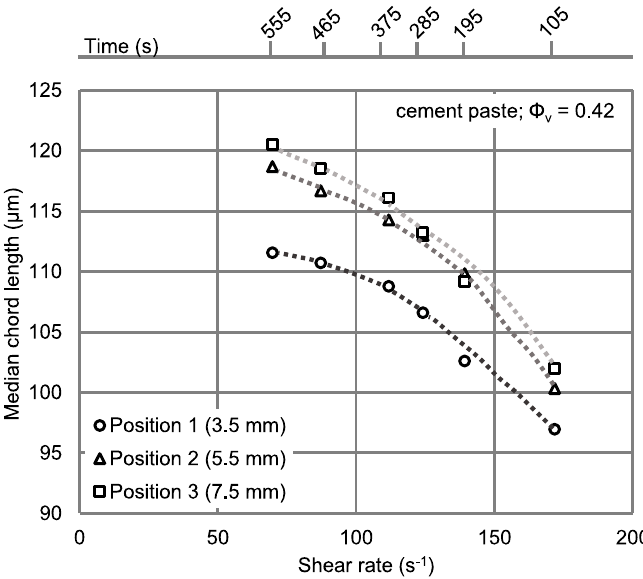
Figure 7. Averaged median chord length for different average shear rates in three different radial positions over the gap; the time shows the beginning of the experiments in the coupled FBRM- rheometer.